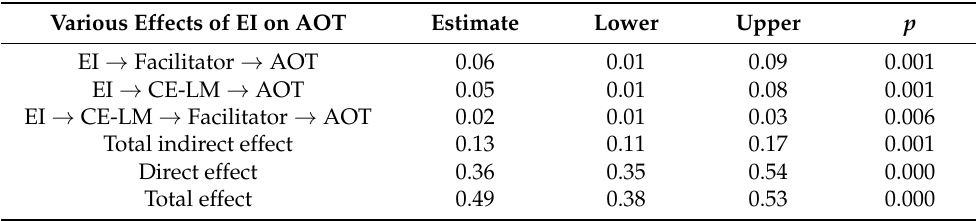
Table 3. Direct, indirect, and total effect of EI on AOT.